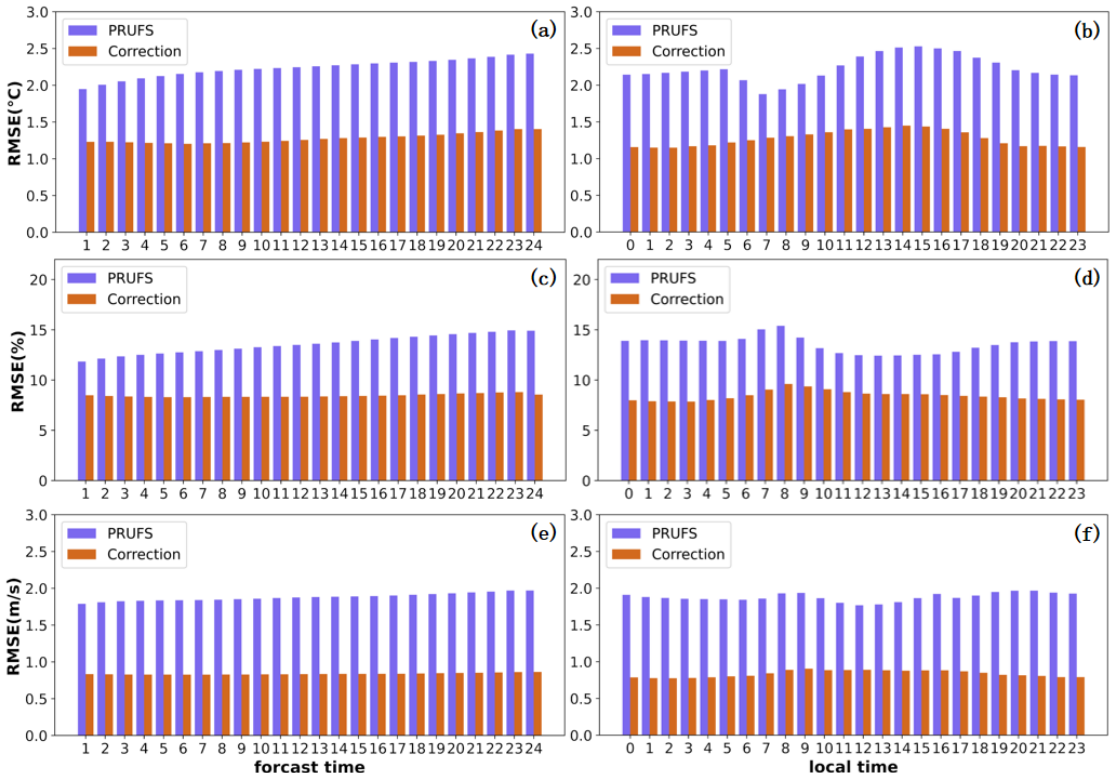
Figure 6. The variation of the RMSE of the PRUFS 0–24 h forecasts and the G2N correction for 2 m temperature ( a , b ), 2 m relative humidity ( c , d ), and 10 m wind speed ( e , f ) with forecast lead time (left panels) and diurnal variation (right panels); The horizontal coordinate of the left panels is the forecast lead time and that of the right panels is the local time.